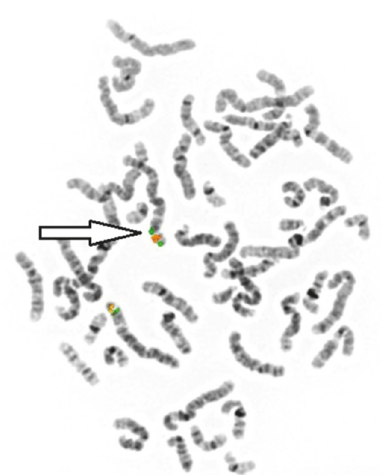
Figure 2: FISH analysis demonstrating the3p26.1 to 3p24.3inverted duplication. The probes, RP11-451A20 at 3p24.3 (green) and RP11- 266J6 at 3p25.3 (red), demonstrated 2 signals for each in a green, red, red, green